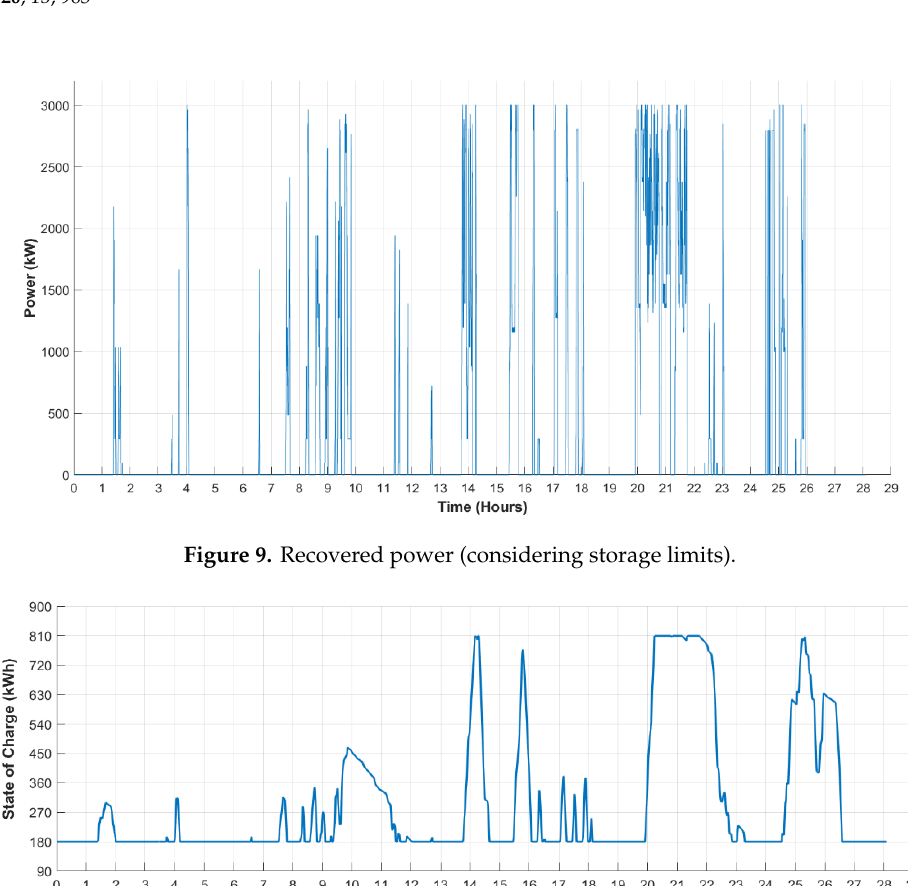
Figure 8. Storage system optimal sizing.